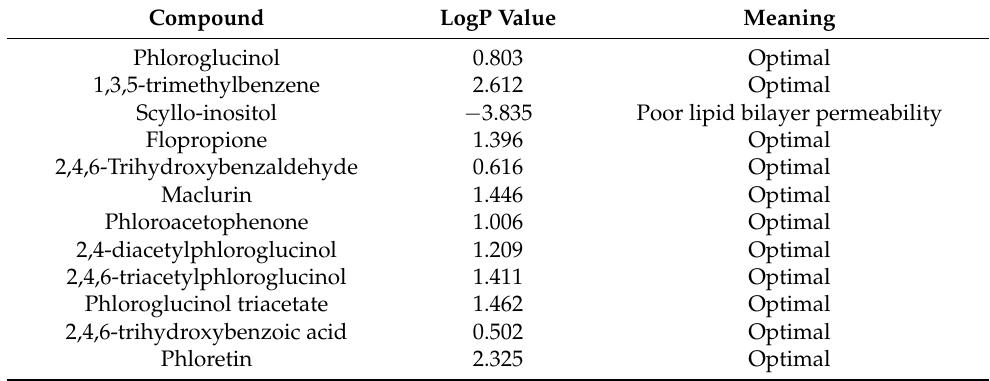
Table 1. Permeability prediction of phloroglucinol derivatives using LogP (distribution coefficient P) value. Values mean lipid bilayer permeability (0 < LogP < 3, optimal; LogP < 0, poor lipid bilayer permeability; LogP > 3, poor aqueous